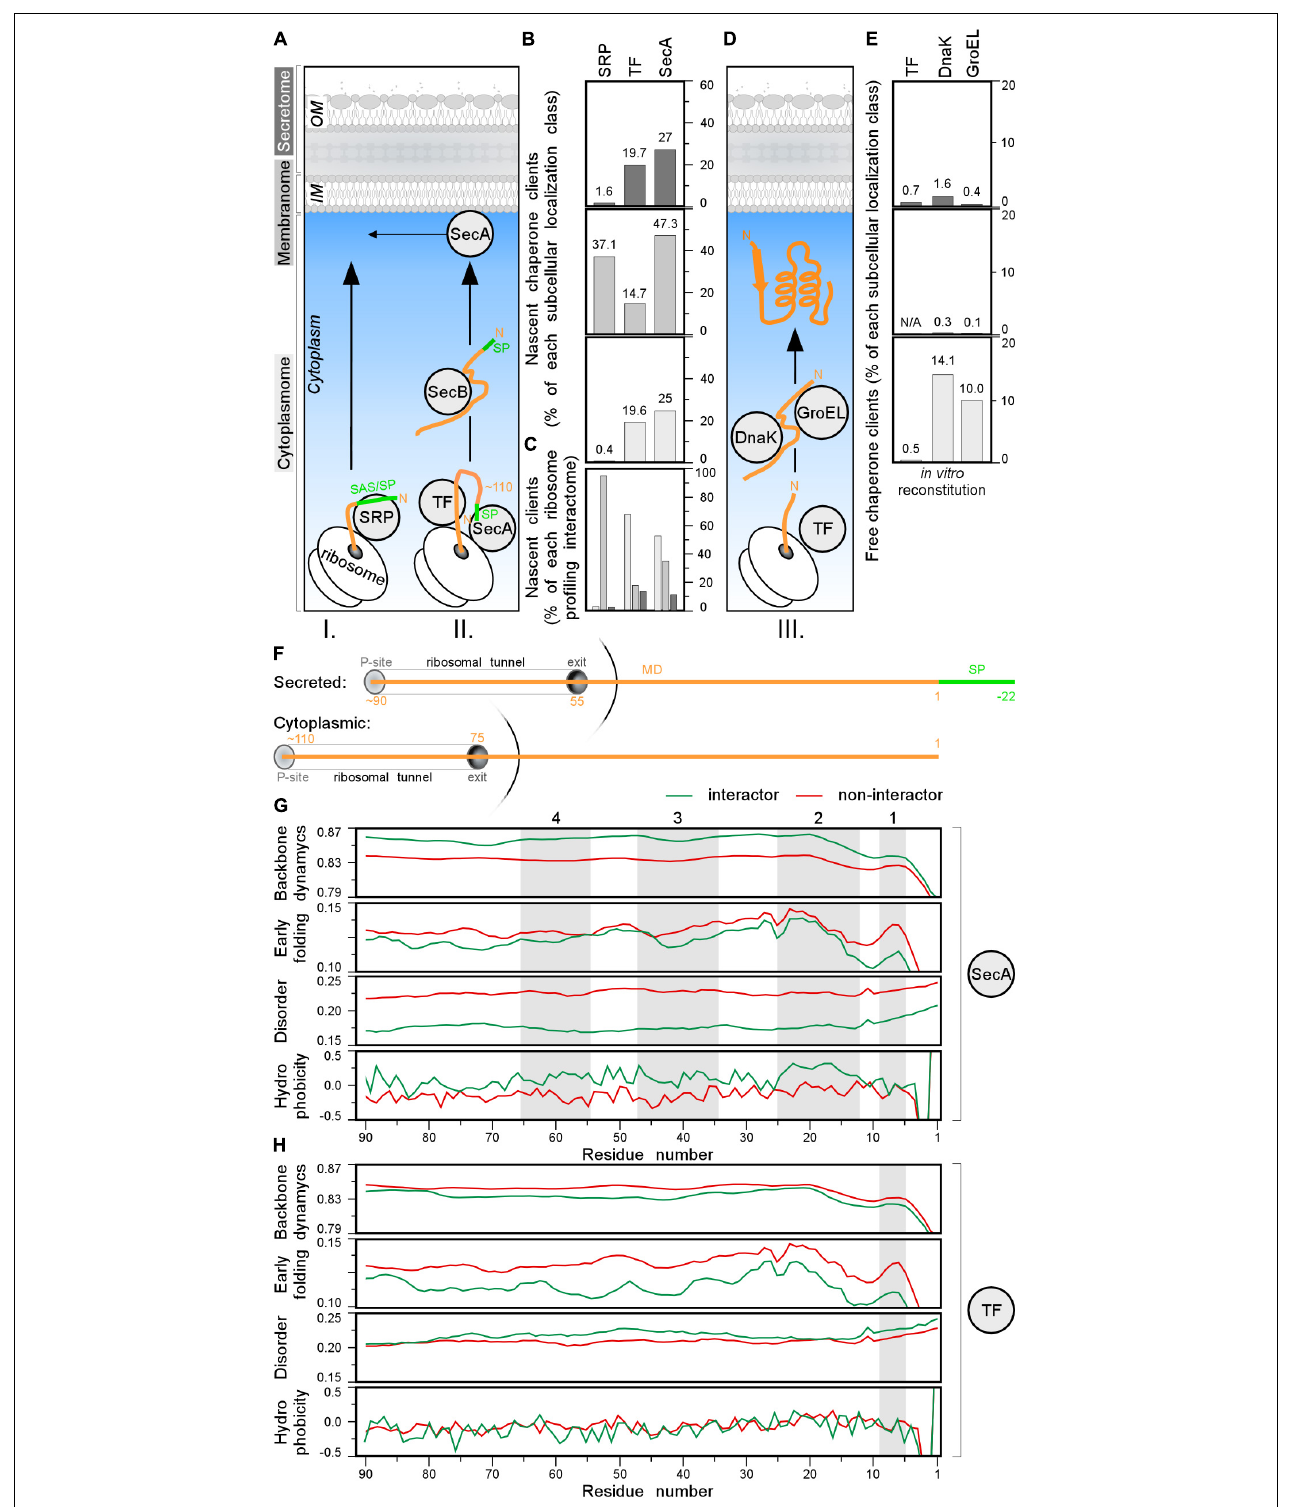
FIGURE 7 | Chaperone clients and their features. (A) Left: representation of different topology groups in gray scale that is used in the graphs. Right: cartoon representation of different chaperones interacting with nascent chains co-translationally. (B,C) Nascent interactomes of the indicated chaperones in each subcellular localization group ( Supplementary Table S16 ). Nascent interactomes determined by ribosome profiling (Oh et al., 2011; Schibich et al., 2016; Huber et al., 2017)